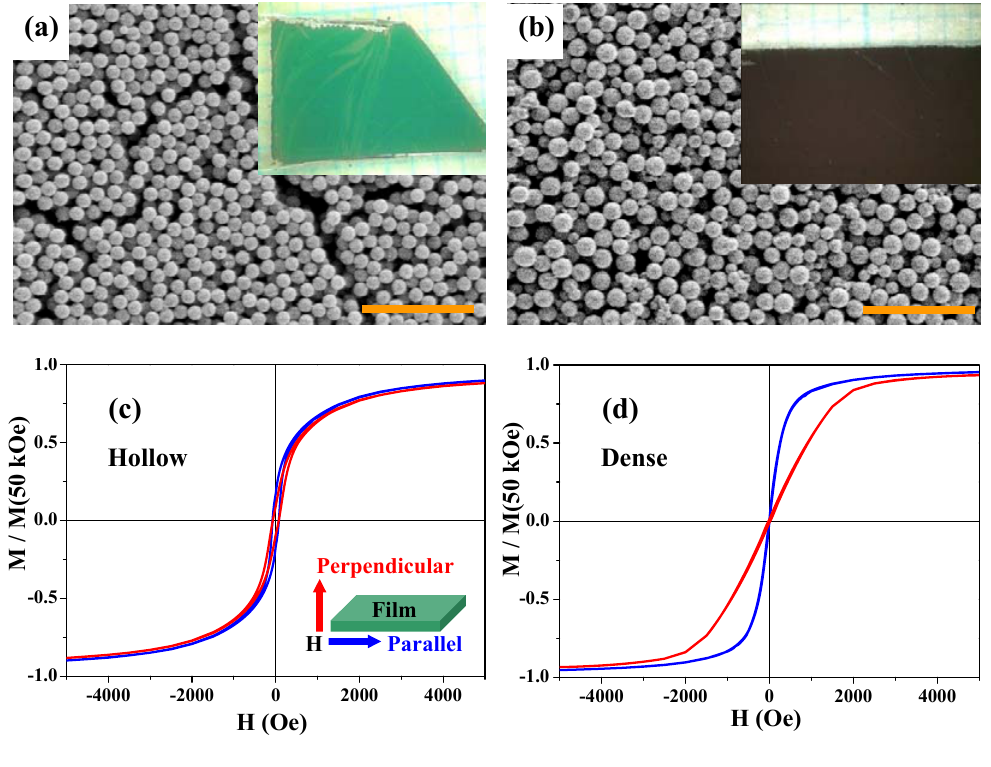
Figure 10. SEM images of thin films of the hollow (a) and dense (b) spheres. The scale bars are 5 μ m in (a) and (b). The insets in (a) and (b) are photographs of the corresponding films. (c) and (d) are M - H curves at 300 K for the thin films of the hollow spheres and the dense particles, respectively, with magnetic field H parallel (blue curves) and perpendicular (red curves) to the film plane (see the inset of (c)). Magnetizations are normalized by the value at 50